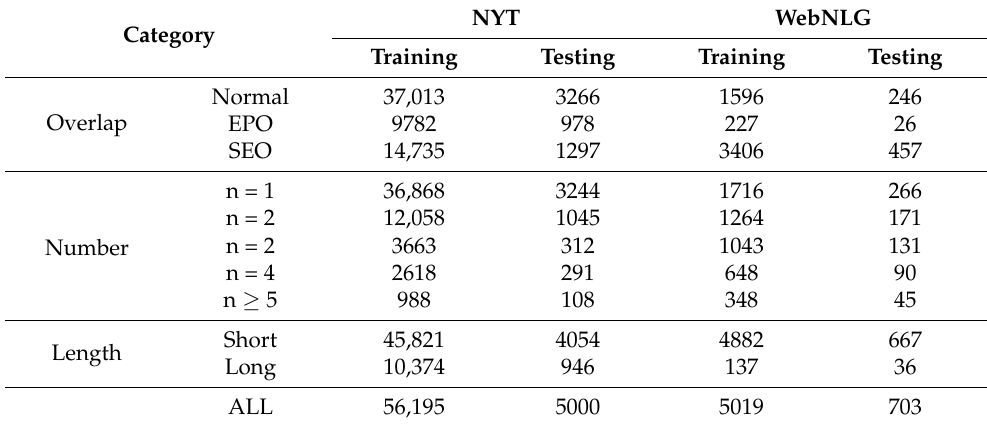
Table 1. Statistics for datasets. Note that a sentence can belong to both the EPO class and the SEO